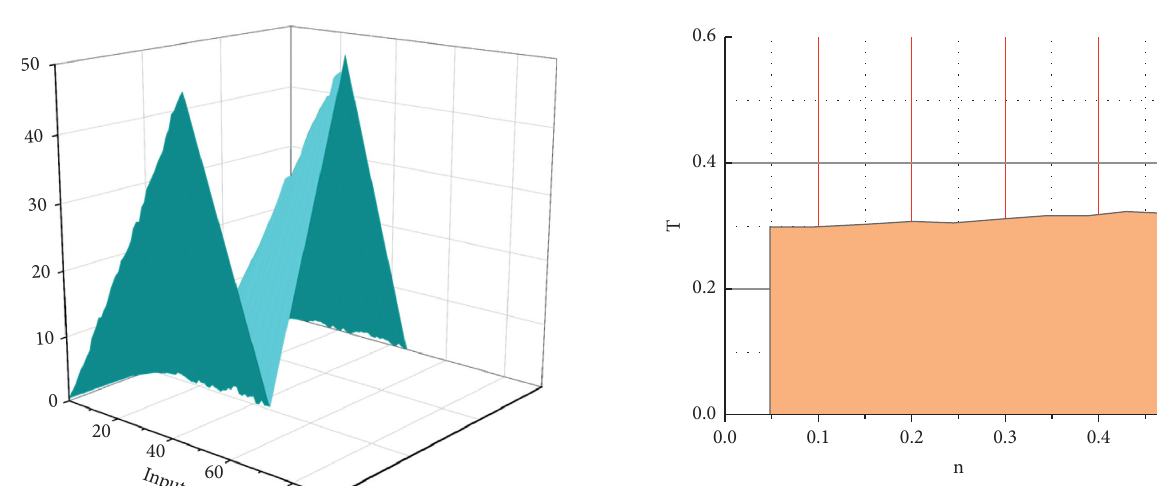
Figure 9: Short-term advertising recovery